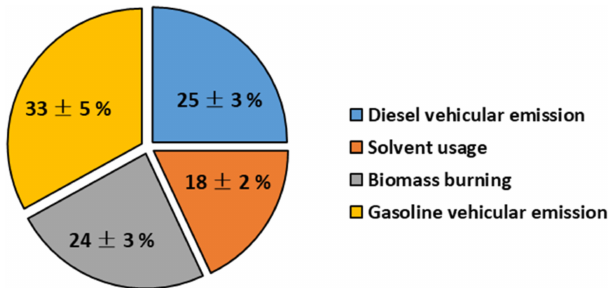
Figure 6. Contributions of different sources to ambient volatile or- ganic compounds (VOCs) extracted from positive matrix factoriza- tion (PMF) in the scenario with